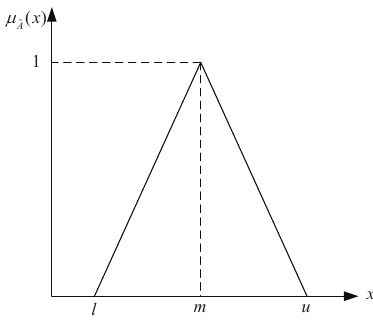
Figure 1. Membership function of a triangular fuzzy number ˜ A = ( l , m , u ) .